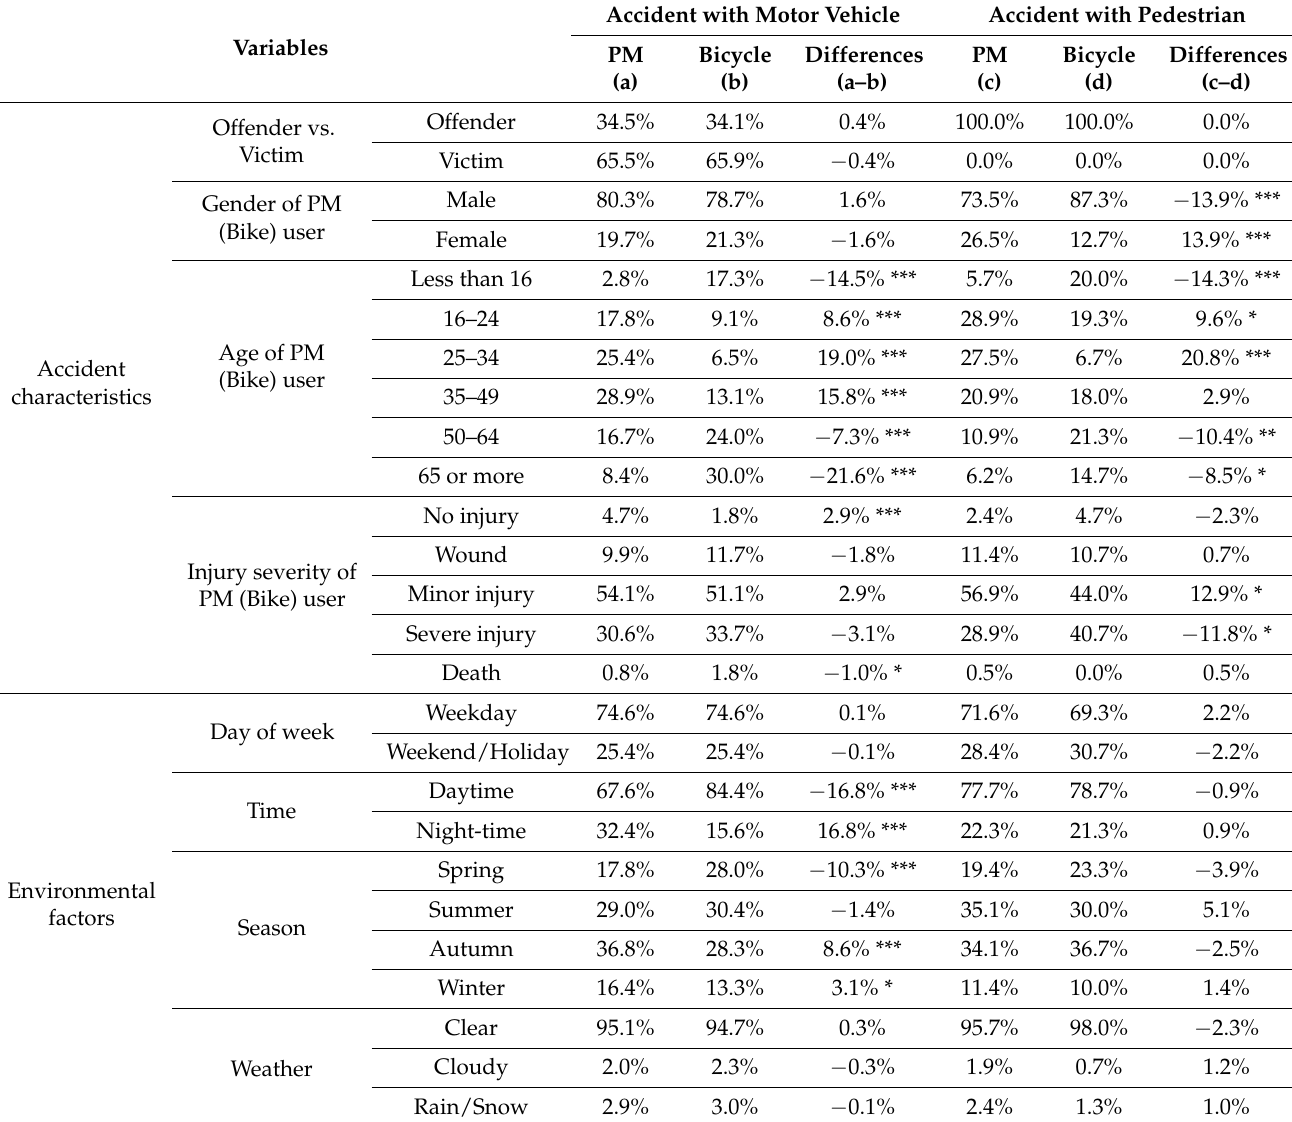
Table 5. Results of two-tailed t -test for comparing PM and bicycle